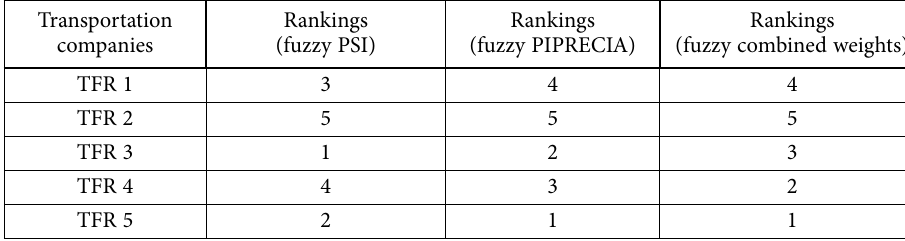
Table 17. The results of fuzzy CoCoSo w.r.t. change in the criteria weights Transportation Rankings Rankings Rankings companies (fuzzy PSI) (fuzzy PIPRECIA) (fuzzy combined weights) TFR 1 3 4 4 TFR 2 5 5 5 TFR 3 1 2 3 TFR 4 4 3 2 TFR 5 2 1